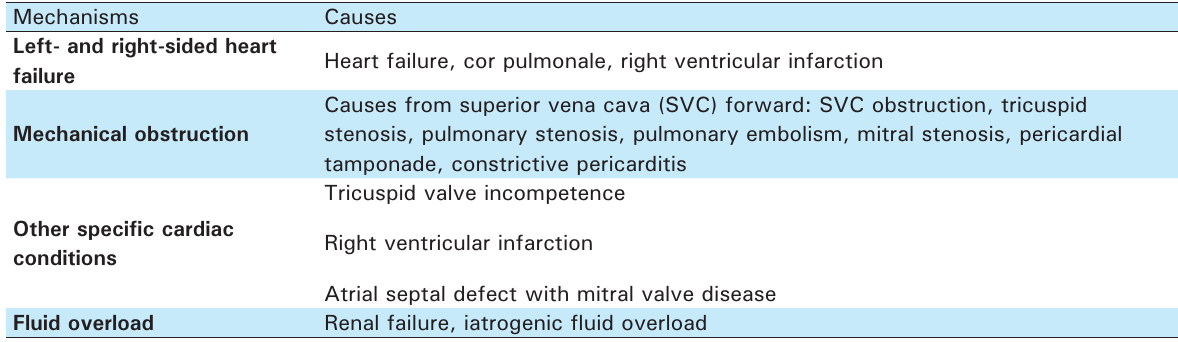
Table 1. Causes of the raised jugular venous pressure Mechanisms